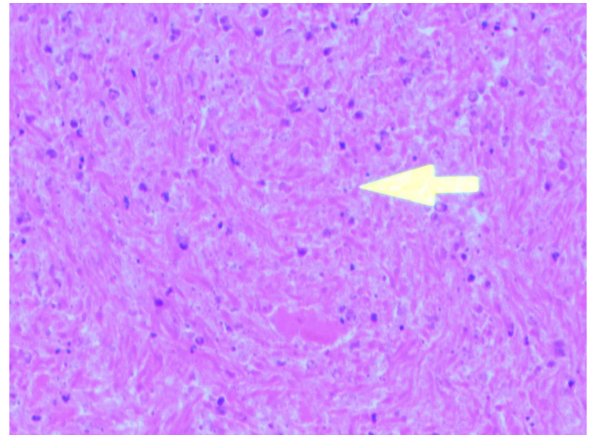
Figure 4: Scattered within the lesion are areas of tumor necrosis